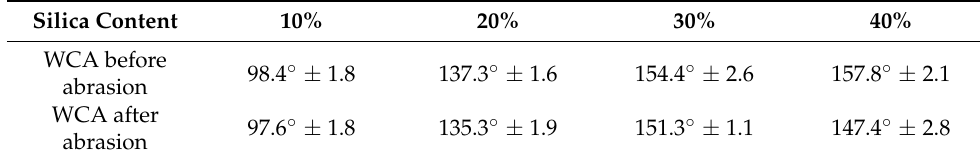
Table 2. WCA of SiO 2 /RF-608 composite before and after abrasion.